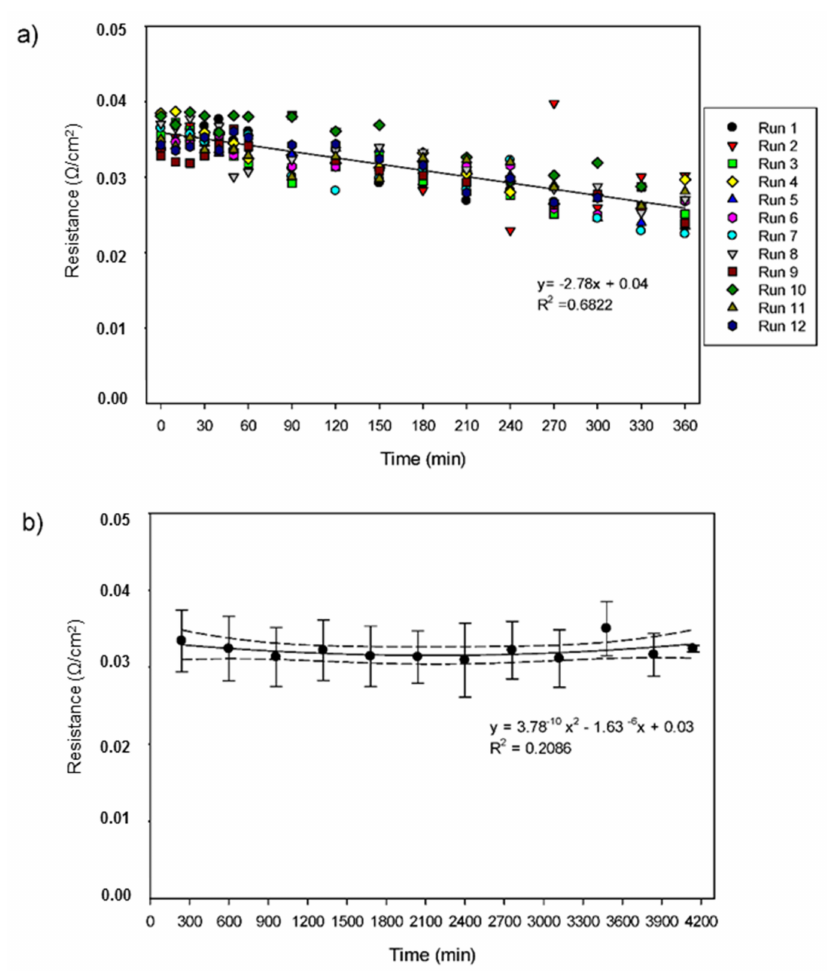
Figure 6. Evolution of the areal system resistance during EDUF process ( a ) for each of the 12 runs and ( b ) for the averaged 12 consecutive runs (4140 min). The dotted lines represent the 95% confidence